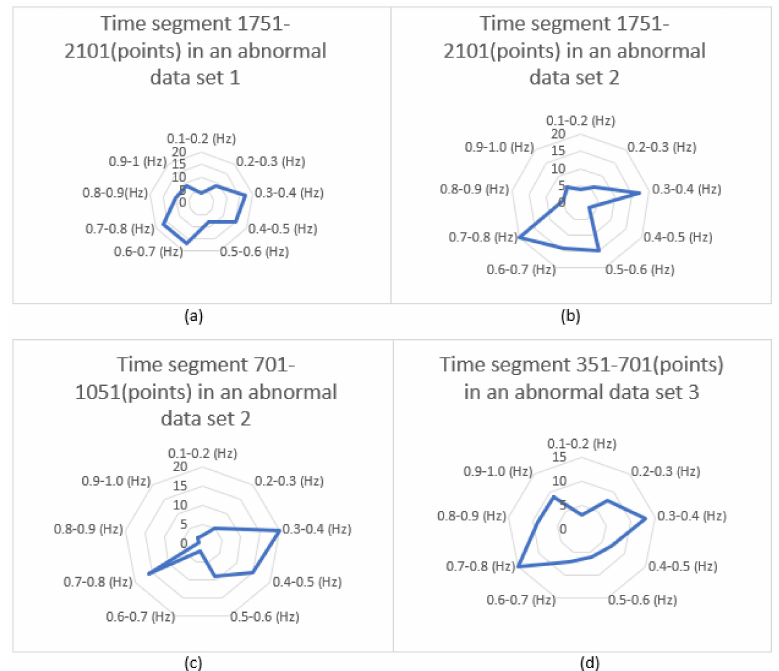
Figure 10. Another set of number of pulses in different frequency ranges for “abnormal” data sets: ( a ) feature 5 in time segment 1751–2101 (points) of abnormal data set 1, ( b ) feature 6 in time segment 1751–2101 (points) of abnormal data set 2, ( c ) feature 7 in time segment 701–1051 (points) of abnormal data set 2, ( d ) feature 8 in time segment 351–701 (points) of abnormal data set